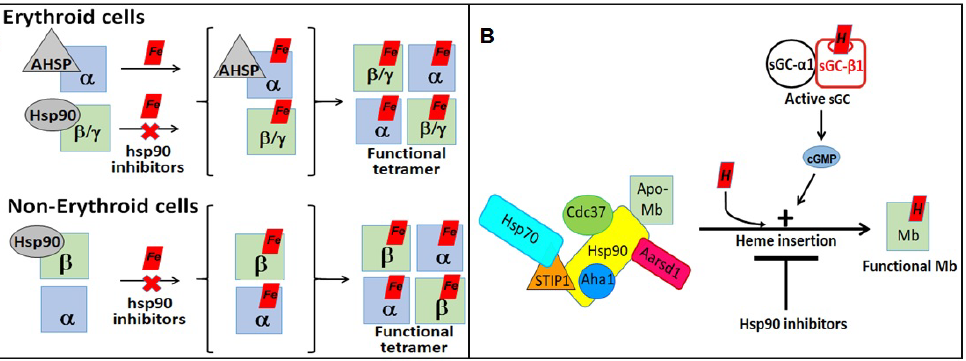
Figure 4. ( A , B ) Representations depicting the role of Hsp90 in hemoglobin (Hb) and myoglobin (Mb)